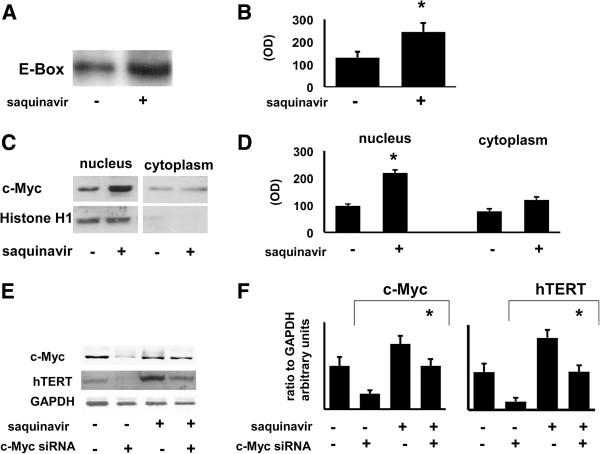
Role of c-Myc in saquinavir activity. A. Representative gel showing the binding of nuclear extracts of Jurkat cells to the oligonucleotide 5’- TCCTGCTGCGCACGTGGGAAGCCCT-3’, containing the downstream “CACGTG” E-Box sequence localized at position −34 of hTERT promoter, 24 h following exposure to saquinavir determined using EMSA. Saquinavir up-regulates the binding of nuclear proteins to the E-Box sequence. B. Graph shows the mean ± SD of the OD obtained from 3 EMSA independent experiments. C. Representative experiment showing the effect of saquinavir on c-Myc transcription factor expression tested on nuclear and cytoplasmic extracts of 2×106 viable Jurkat cells after 24 h of treatment (Western Blot). Quality of nuclear extracts was tested using anti Histone H1 Ab. D. Graphs show the mean ± SD of c-Myc OD values obtained from 3 experiments of and all p values were calculated using Student’s t-test. E. Representative experiment showing the role of c-Myc on saquinavir-mediated hTERT up-regulation. Jurkat cells were transfected with siRNA targeting c-Myc mRNA as described in Material and Methods. c-Myc silencing induces marked down-regulation of c-Myc protein and hTERT which is a target of the transcriptional factor. Saquinavir restores c-Myc and hTERT expression to control levels. F. Pooled results relative to 2 separate experiments of c-Myc silencing. Asterisk indicates p < 0.05.